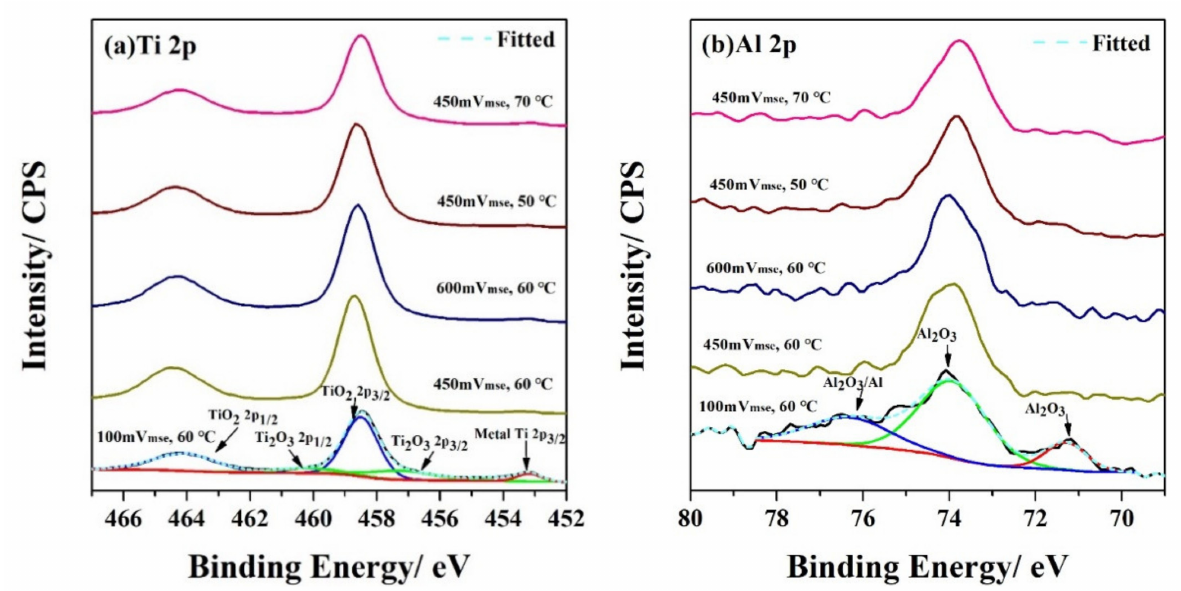
Figure 19. High-resolution XPS profiles for Ti 2p ( a ) and Al 2p ( b ) of the surface of the TC4 alloy after potentiostatic